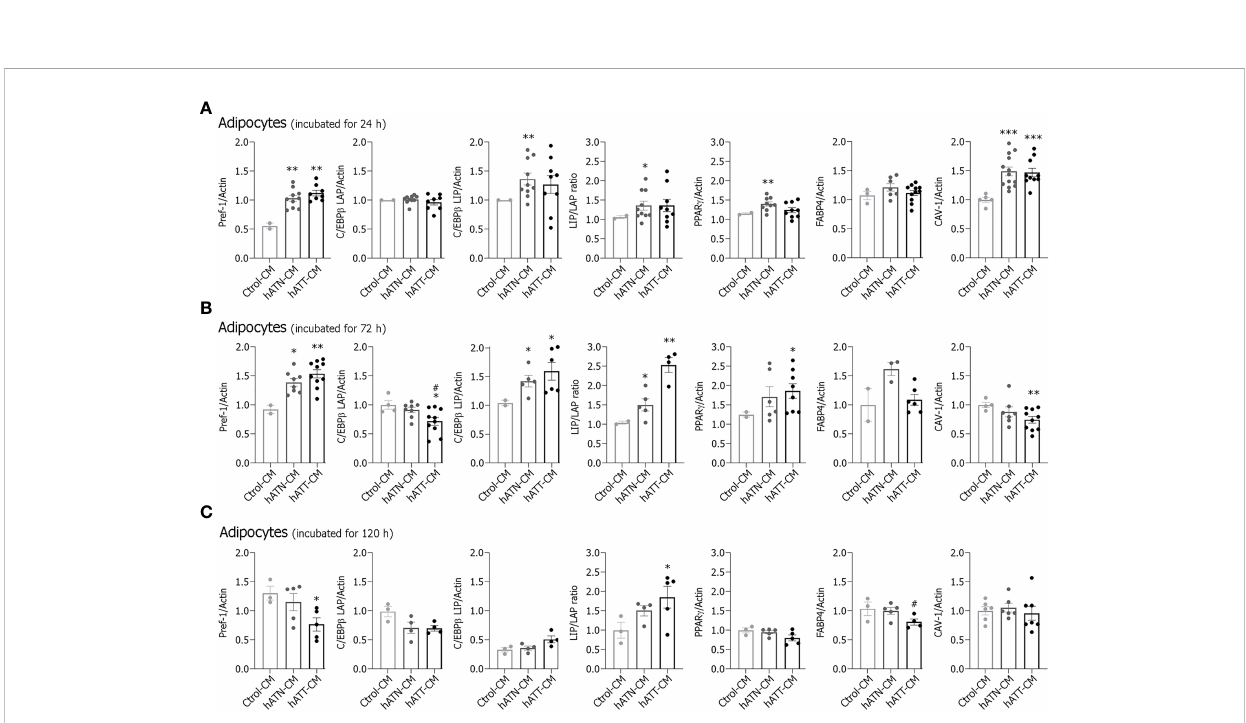
FIGURE 4 Effect of CM from hATN and hATT on the protein expression of adipogenic and mature adipocyte markers. 3T3-L1 adipocytes were incubated with hATN-, hATT- or Ctrol-CM for 24 (A) , 72 (B) and 120 h (C) and, then, lysed. The expression of the different proteins was measured by WB. Actin was used as a loading control. Images were analyzed by densitometry. (n = 4-5 experiments in duplicate). Student ’ s t-test with Welch´s correction was performed; *P<0.05, **P<0.01, and ***P<0.001, adipocytes incubated with hATT-CM or hATN-CM vs. Ctrol-CM; #P<0.05, adipocytes incubated with hATT-CM vs. hATN-CM. Ctrol-CM, control conditioned media; hATN-CM, conditioned media from human normal breast adipose tissue explants; hATT-CM, conditioned media from human breast cancer adipose tissue explants; Pref-1, preadipocyte factor 1; C/EBP b , CCAAT/enhancer binding protein b ; LAP, liver activating protein; LIP, liver inhibitory protein; PPAR g , peroxisome proliferator activated receptor g ; FABP4, fatty acid binding protein 4; CAV-1, Caveolin